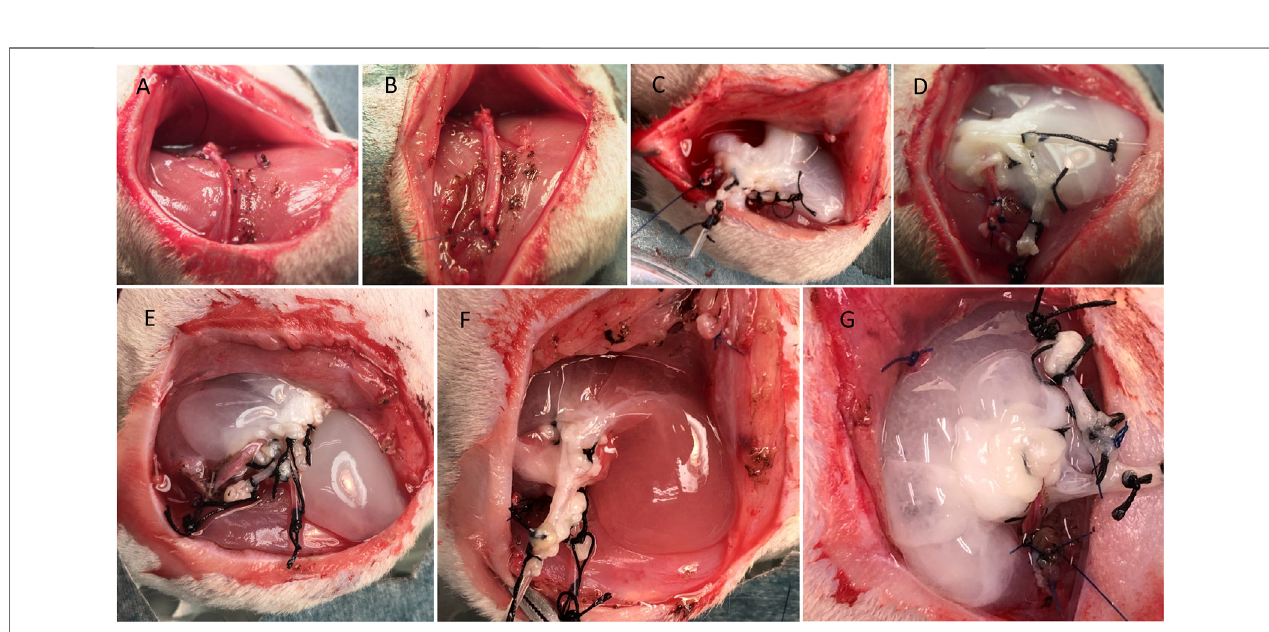
FIGURE 3 | Cell preparations used in the study; BM: fresh rat bone marrow, ADSCs: rat adipose-derived stem cells.